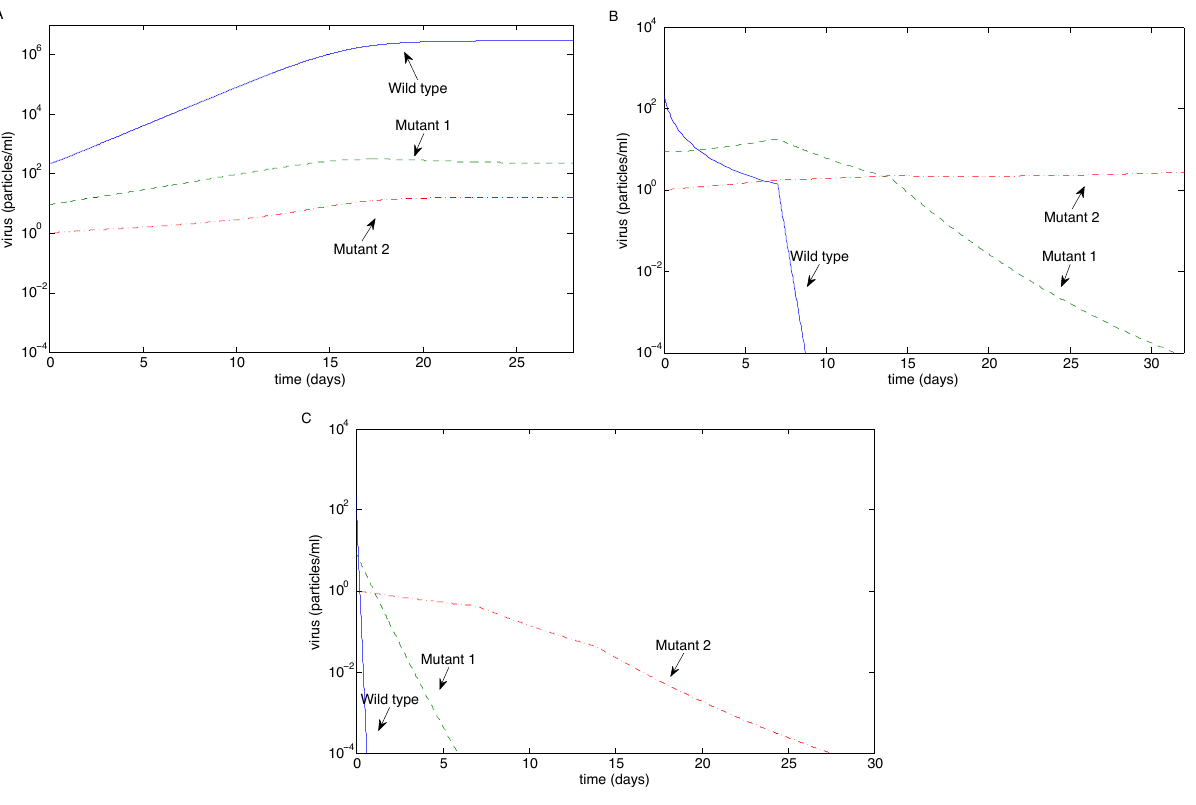
Figure 4. The long-term outcome using the sample values in Table 1 for the case when Mutant 1 has 10 -fold resistance and Mutant 2 has 100 -fold resistance ( p p = 0 . 01 p ) as the antibody magnification factor m varies. ( A ) m = 1 ; ( B ) m = 10 ; M 2 W ( C ) m = 50